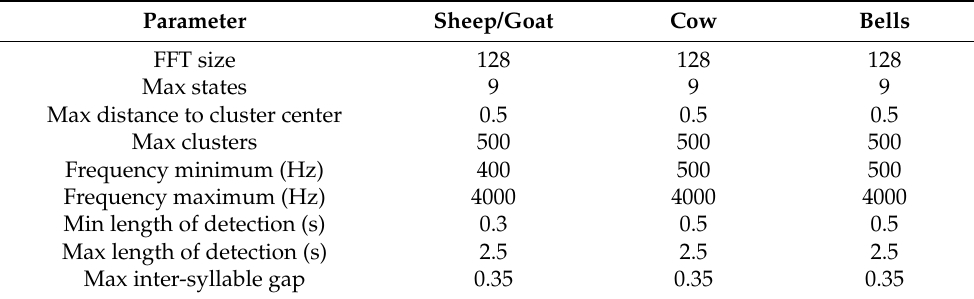
Table 1. Parameter settings used for cow lowing, sheep/goat bleats and livestock bell rings acoustic detection algorithms built in Kaleidoscope software. Parameter Sheep/Goat Cow Bells FFT size 128 128 128 Max states 9 9